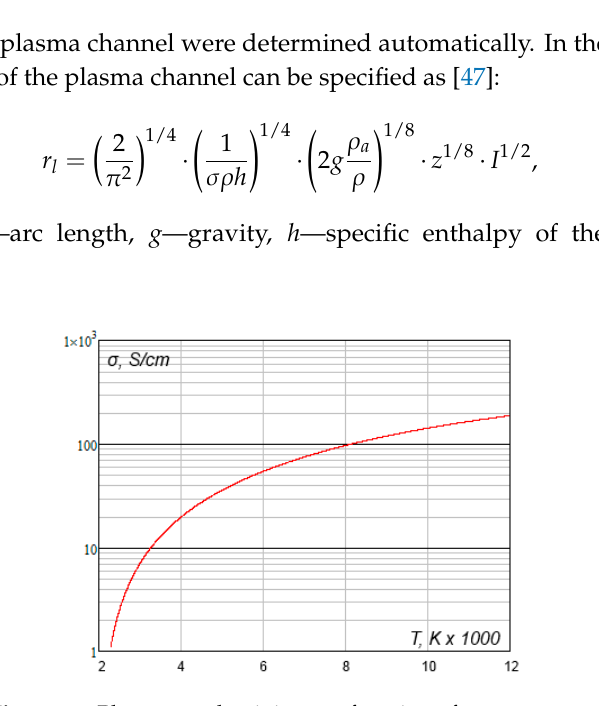
Figure 15. Plasma conductivity as a function of temperature.